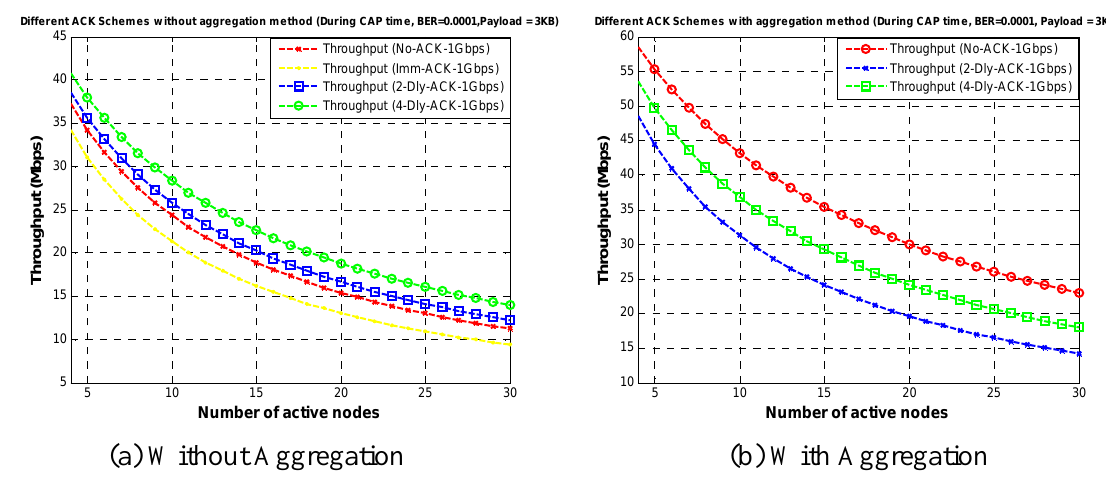
Figure 13. Throughput versus number of active nodes.